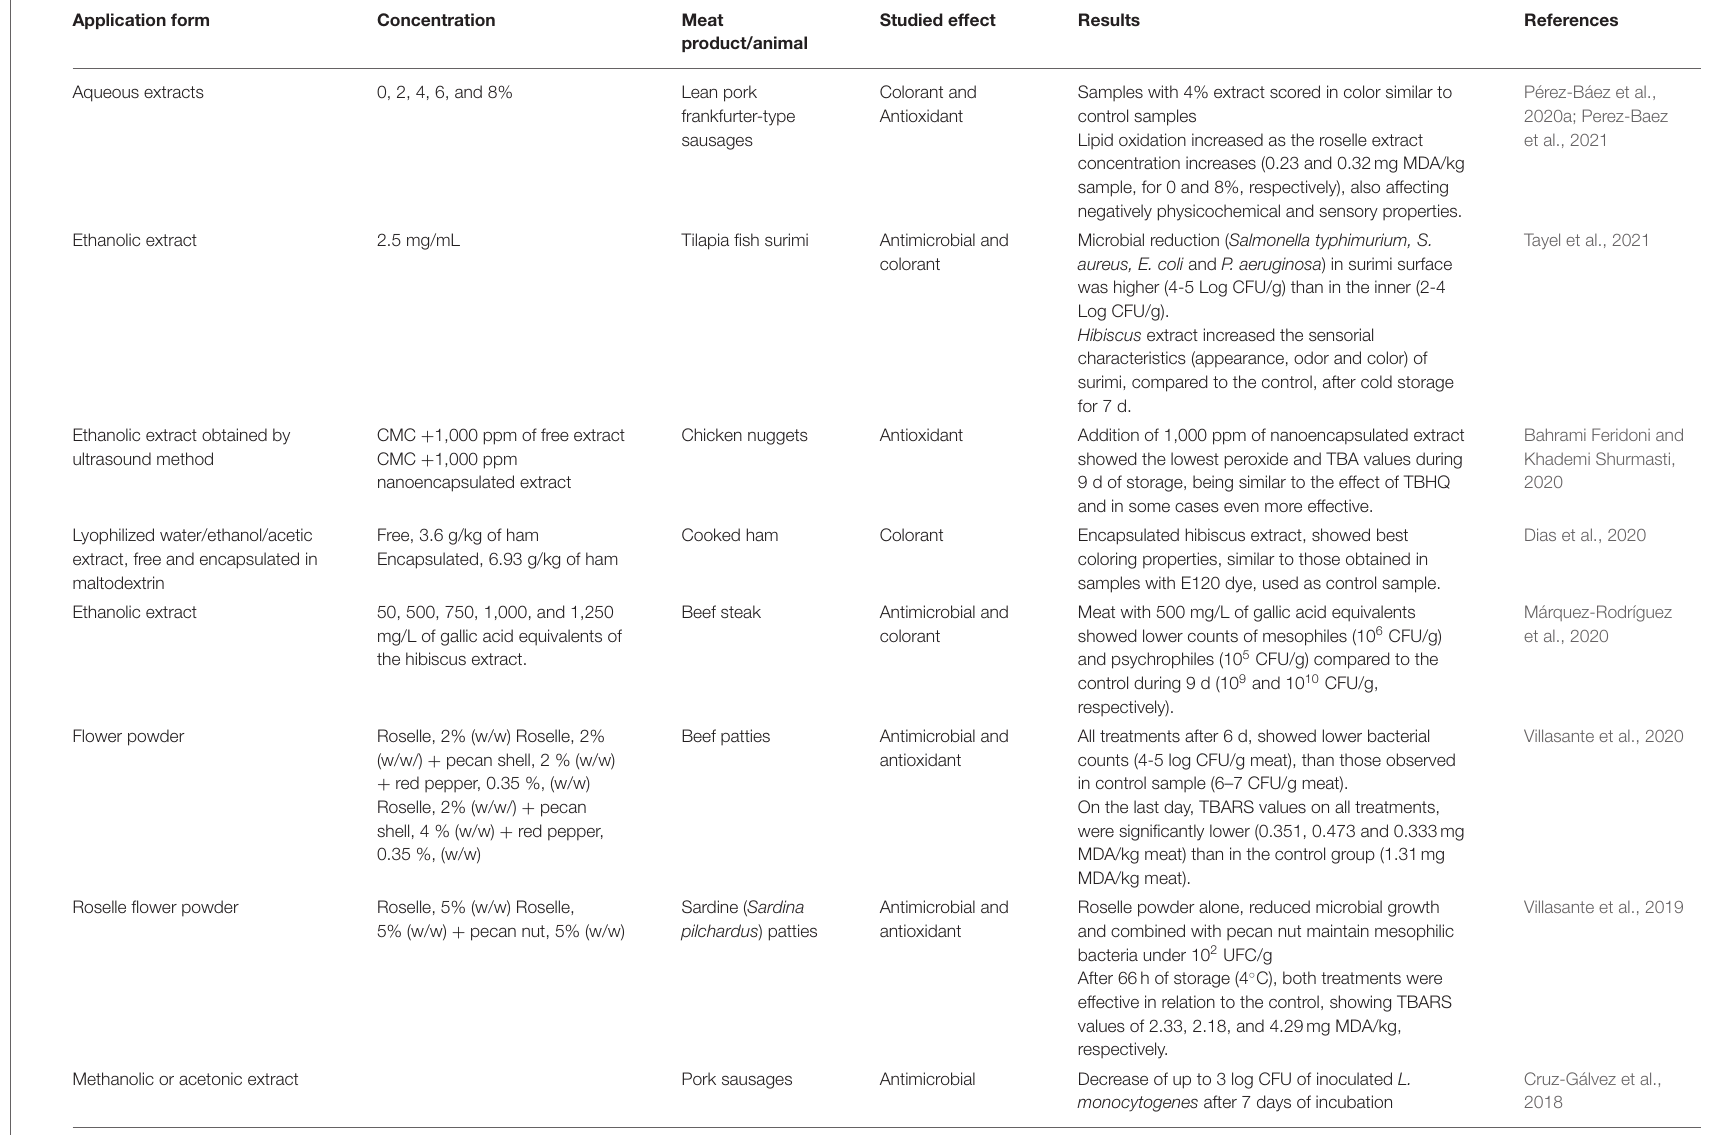
TABLE 1 | Application of Hibiscus sabdariffa calyxes in meat, meat products and diets for animal